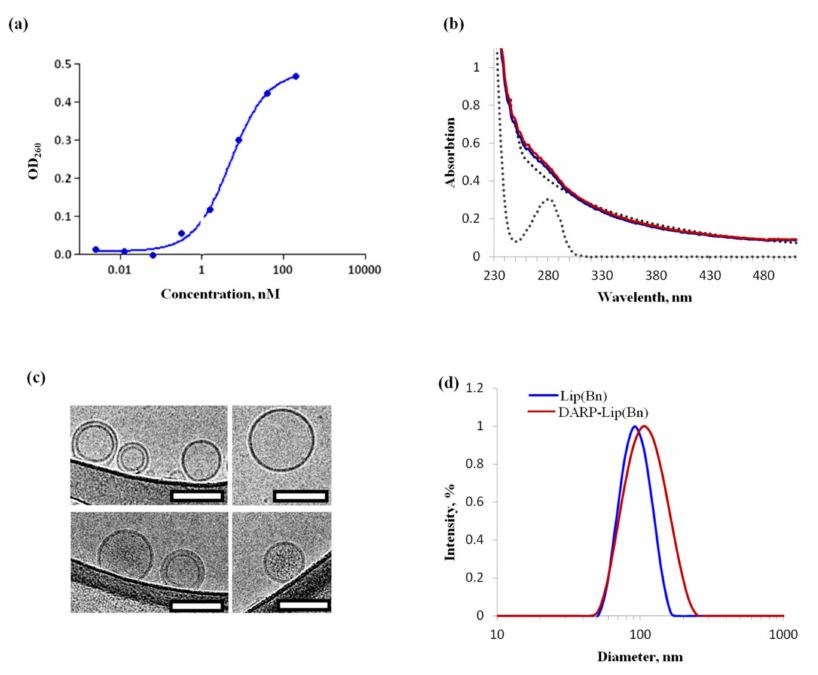
Figure 1. In vitro characteristics of liposomes loaded with Bn. ( a ) Ribonuclease activity of Bn. ( b ) Absorption spectroscopy of Bn-loaded liposomes (blue curve). Red curve is a sum of spectral curves corresponding to 6 µ M Bn and 1 mg / mL liposomes (dotted grey curves). ( c ) Cryo-EM images of “empty” (upper panel) and Bn-containing liposomes (lower panel) at pH = 7.5. Scale bar = 100 nm. ( d ) Hydrodynamic size distribution by the intensity of DARP-Lip(Bn) and Lip(Bn) measured with the DLS